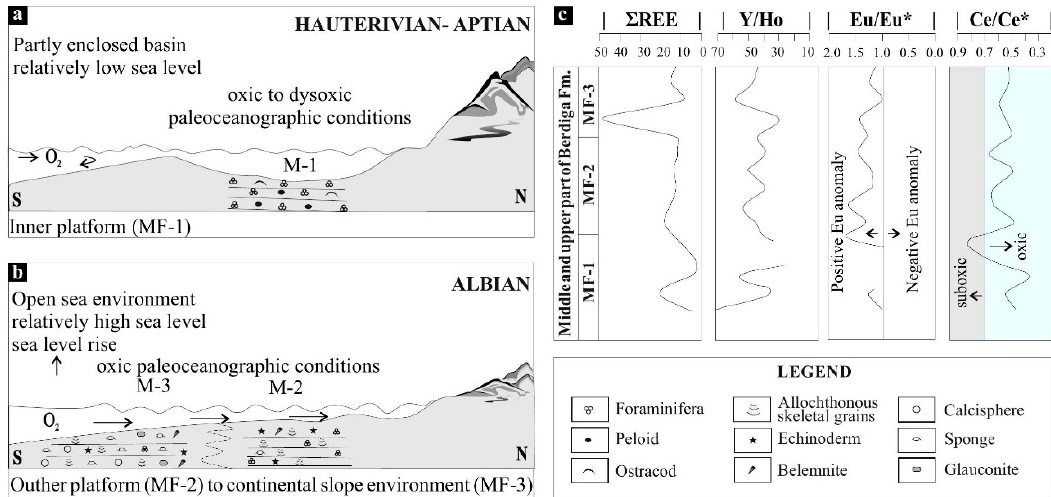
Figure 10. Diagrammatic sketch illustrating probable environment evolution of middle and upper part of the Berdiga Formation during the Hauterivian-Albian in Eastern Pontide. ( a ) During MF-1 deposition, the inner platform environment with relatively low sea level with oxic to dysoxic paleoceanographic conditions. ( b ) During MF-2 and MF-3 deposition, an outer platform to continental slope environment with relatively high relative sea level and a well-oxygenated open marine environment. ( c ) Inset showing the relative position of each phase with respect to Σ REE (µg/g) Y/Ho, Eu/Eu* and Ce/Ce* variations. Ce/Ce* shows dyspoxic (Ce* = 0.71–0.81) conditions in most upper part of the MF-1. MF-1: benthic foraminiferal packstone microfacies corresponding to inner platform environment, MF-2: reworked skeletal grainstone/packstone microfacies corresponding to other platform, and MF-3: Sponge spicule wackestone-mudstone microfacies continental corresponding to slope environment.